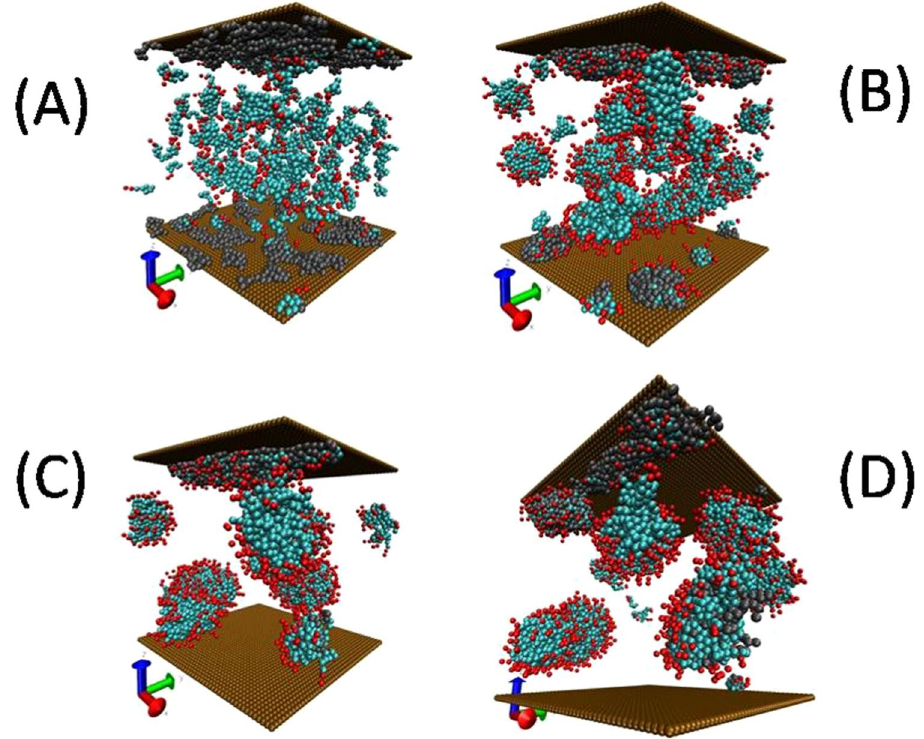
Figure 2. Snapshots of the encapsulation of HC through association with short chain non-ionic surfactants. These snapshots were taken from final configurations of the simulation at increasing surfactant concentration. Gray molecules represent the mixture of HC chains, while cyan beads correspond to the hydrophobic tail of the surfactants, and read beads are the hydrophilic heads. The surfactant – driven desorption process is seen in ( C , D